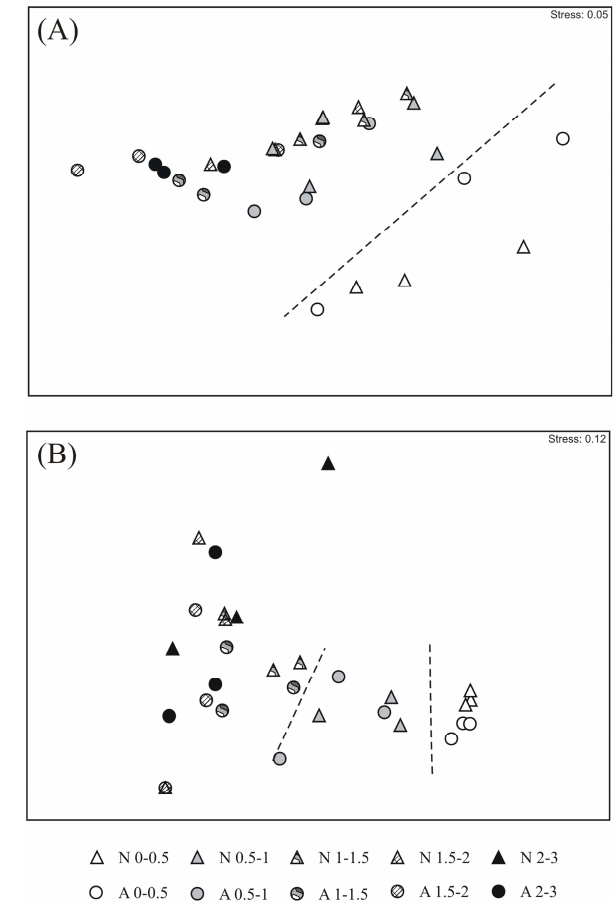
Fig. 4. MDS of relative (A) meiofauna and (B) copepod Figure 4. MDS of relative (A) meiofauna and (B) copepod community composition based on 3 Bray-Curtis similarity: normoxia (N) and anoxia (A), sediment depth layers indicated in cm. 4